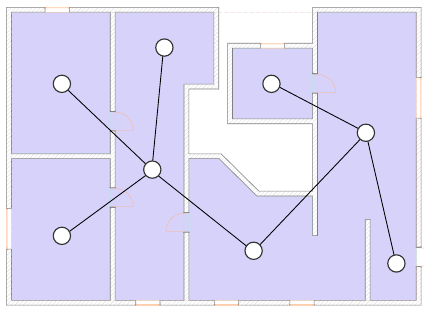
Figure 7: Region-connectivity route graph of a building.